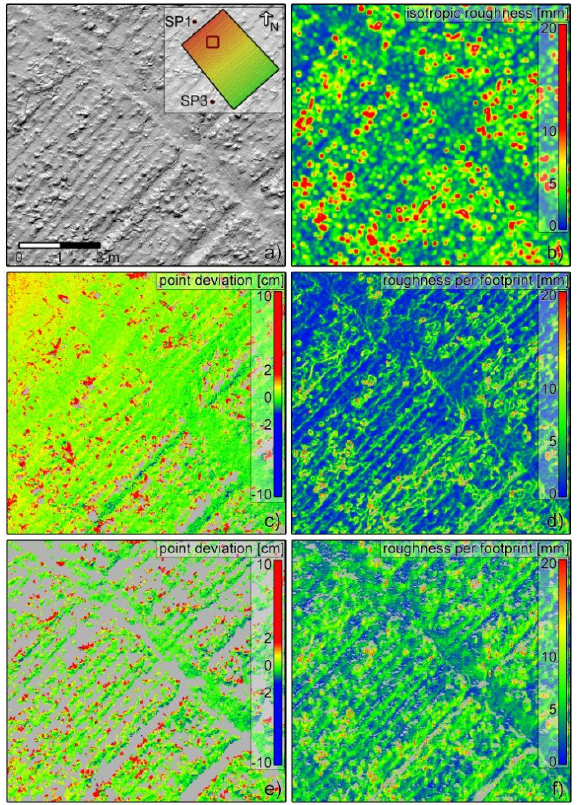
Figure 8: Importance of isotropic and anisotropic roughness as well as distance to scanning device for TLS point quality (field campaign 14.02.2014). a) hill-shaded UAV DEM, b) isotropic roughness, c) TLS point deviations to UAV DEM from SP1, d) roughness per footprint from SP1, e) TLS point deviations to UAV DEM from SP3, f) roughness per footprint from SP3.